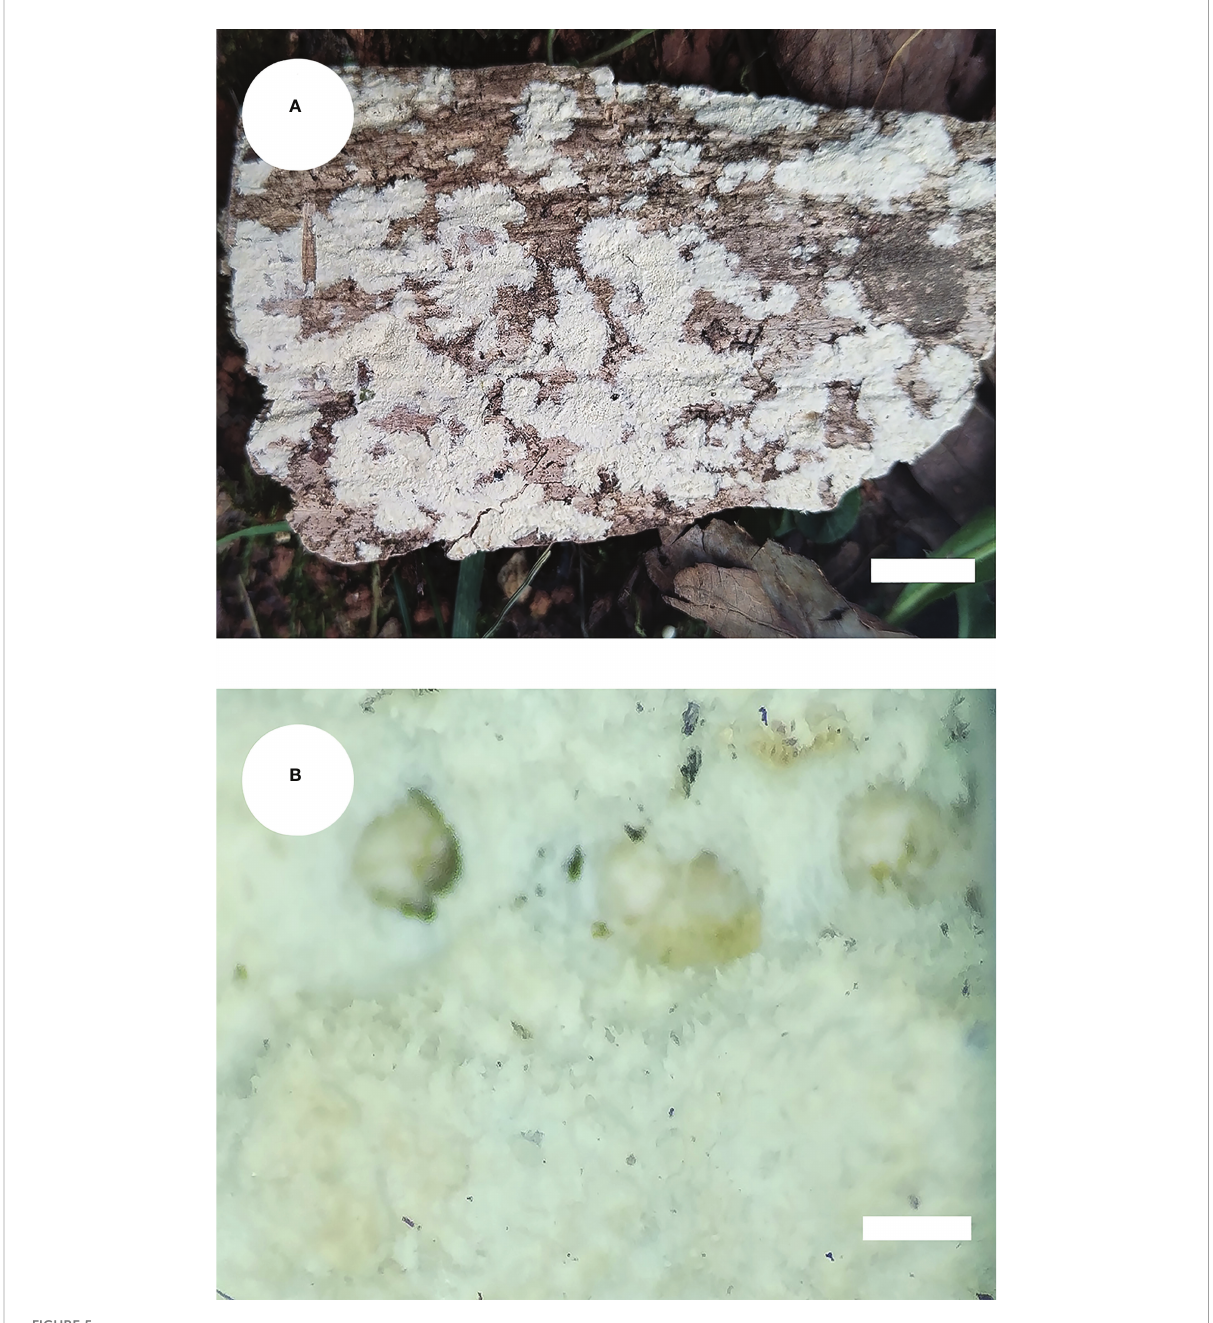
FIGURE 5 Basidiomata of Steccherinum punctatum (holotype). Bars: (A) 1 cm; (B) 0.5